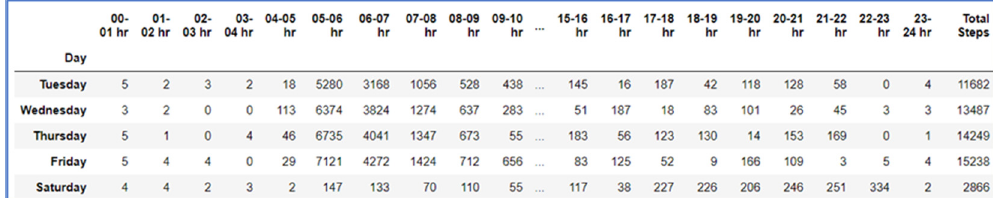
Figure 5. Sample of contextual features dataset (for Total Steps).